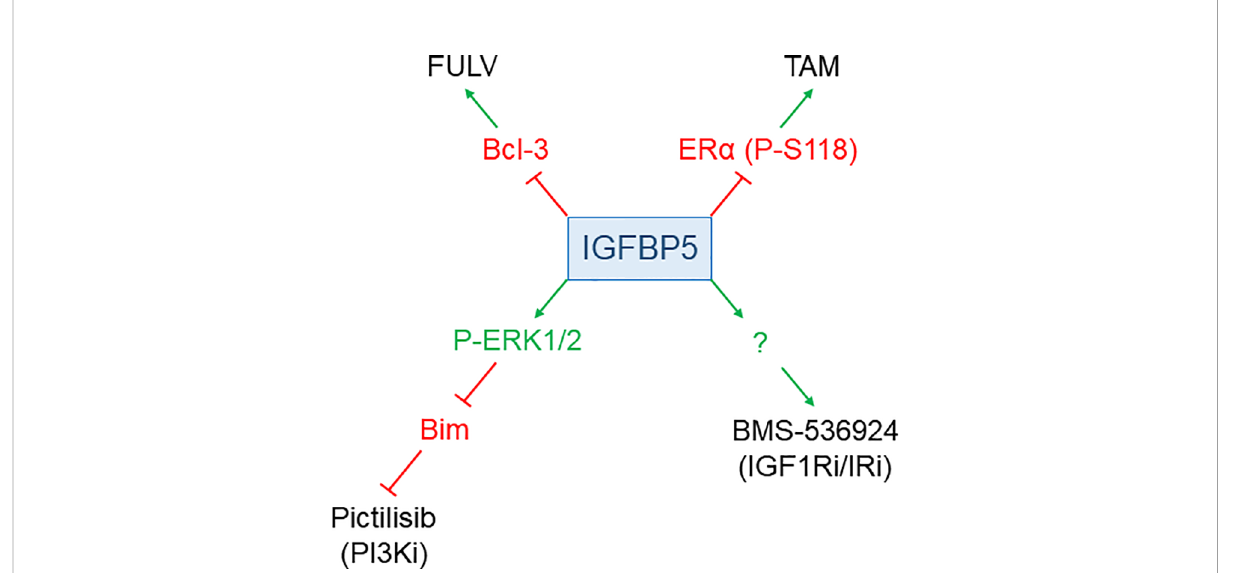
FIGURE 3 IGFBP5 modulates drug responses of BC cells. IGFBP5 counteracts resistance to the anti-estrogens FULV and TAM by either inhibiting the expression of Bcl-3 or by preventing phosphorylation of ER a at S118, respectively. On the other hand, IGFBP5 de-sensitizes cells to the PI3K inhibitor (i) GDC-0941, involving ERK1/2 activation and downregulation of pro-apoptotic Bim, and to the dual IGF1R/IR inhibitor BMS-536924 through a not yet de fi ned